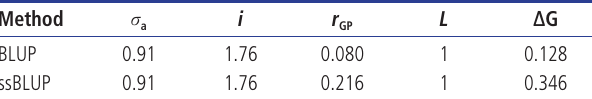
Table 7. Genetic gains of the total number of piglets born (TNB) per year by the selection method of candidate sows